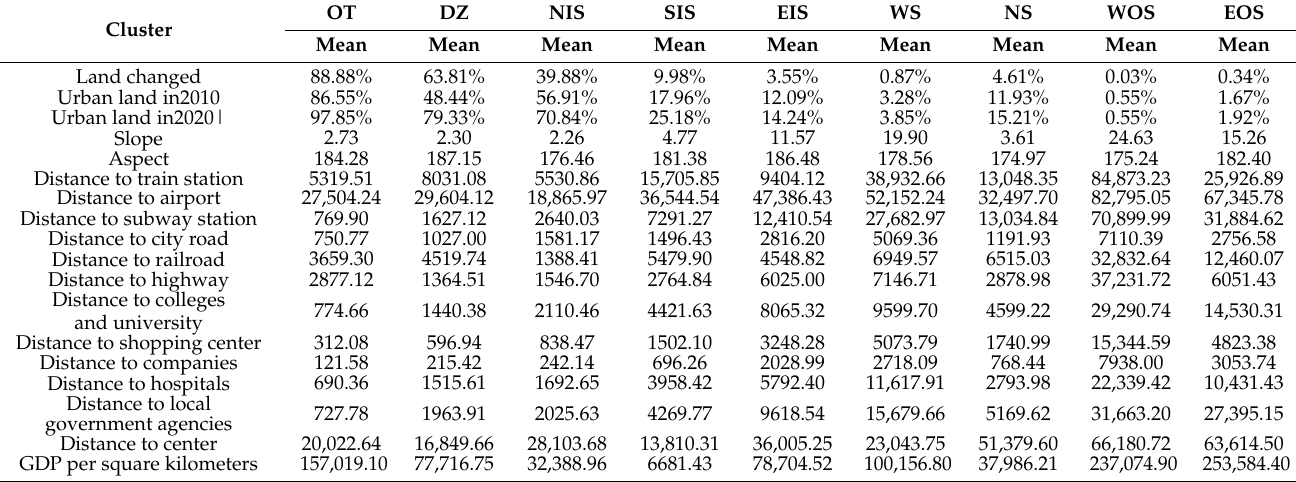
Figure 4. Results of clustering. Table 2. The mean values of every cluster’s characteristics.